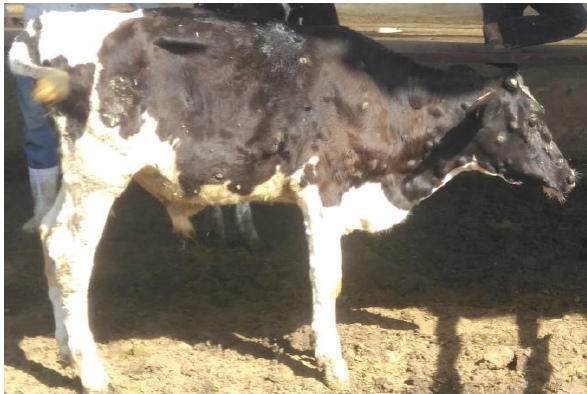
Fig. 1: generalized LD nodule in affected cattle.